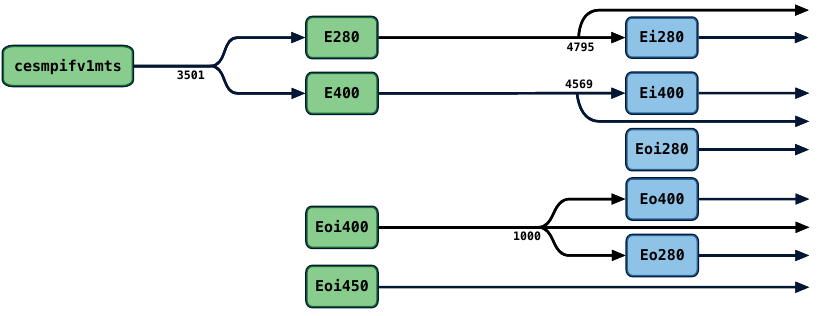
Figure 2. Relationship among our PlioMIP2 simulations. The simulations colored green are previously introduced in Chandan and Peltier (2017), while the blue-colored simulations are new to this paper. The numbers at the locations of branching indicate the model year from which one or more new simulations were branched. All simulations without an ancestor have their ocean components initialized from modern-day conditions (Levitus and Boyer, 1994). The simulation cesmpifv1mts is a non-PlioMIP2 preexisting PI control